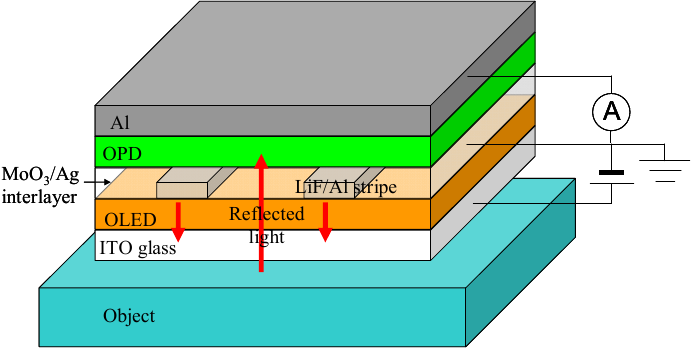
Figure 1. Schematic diagram of the organic optical sensor based on monolithic integration of OLED and OPD units, showing the operation principle of the sensor.